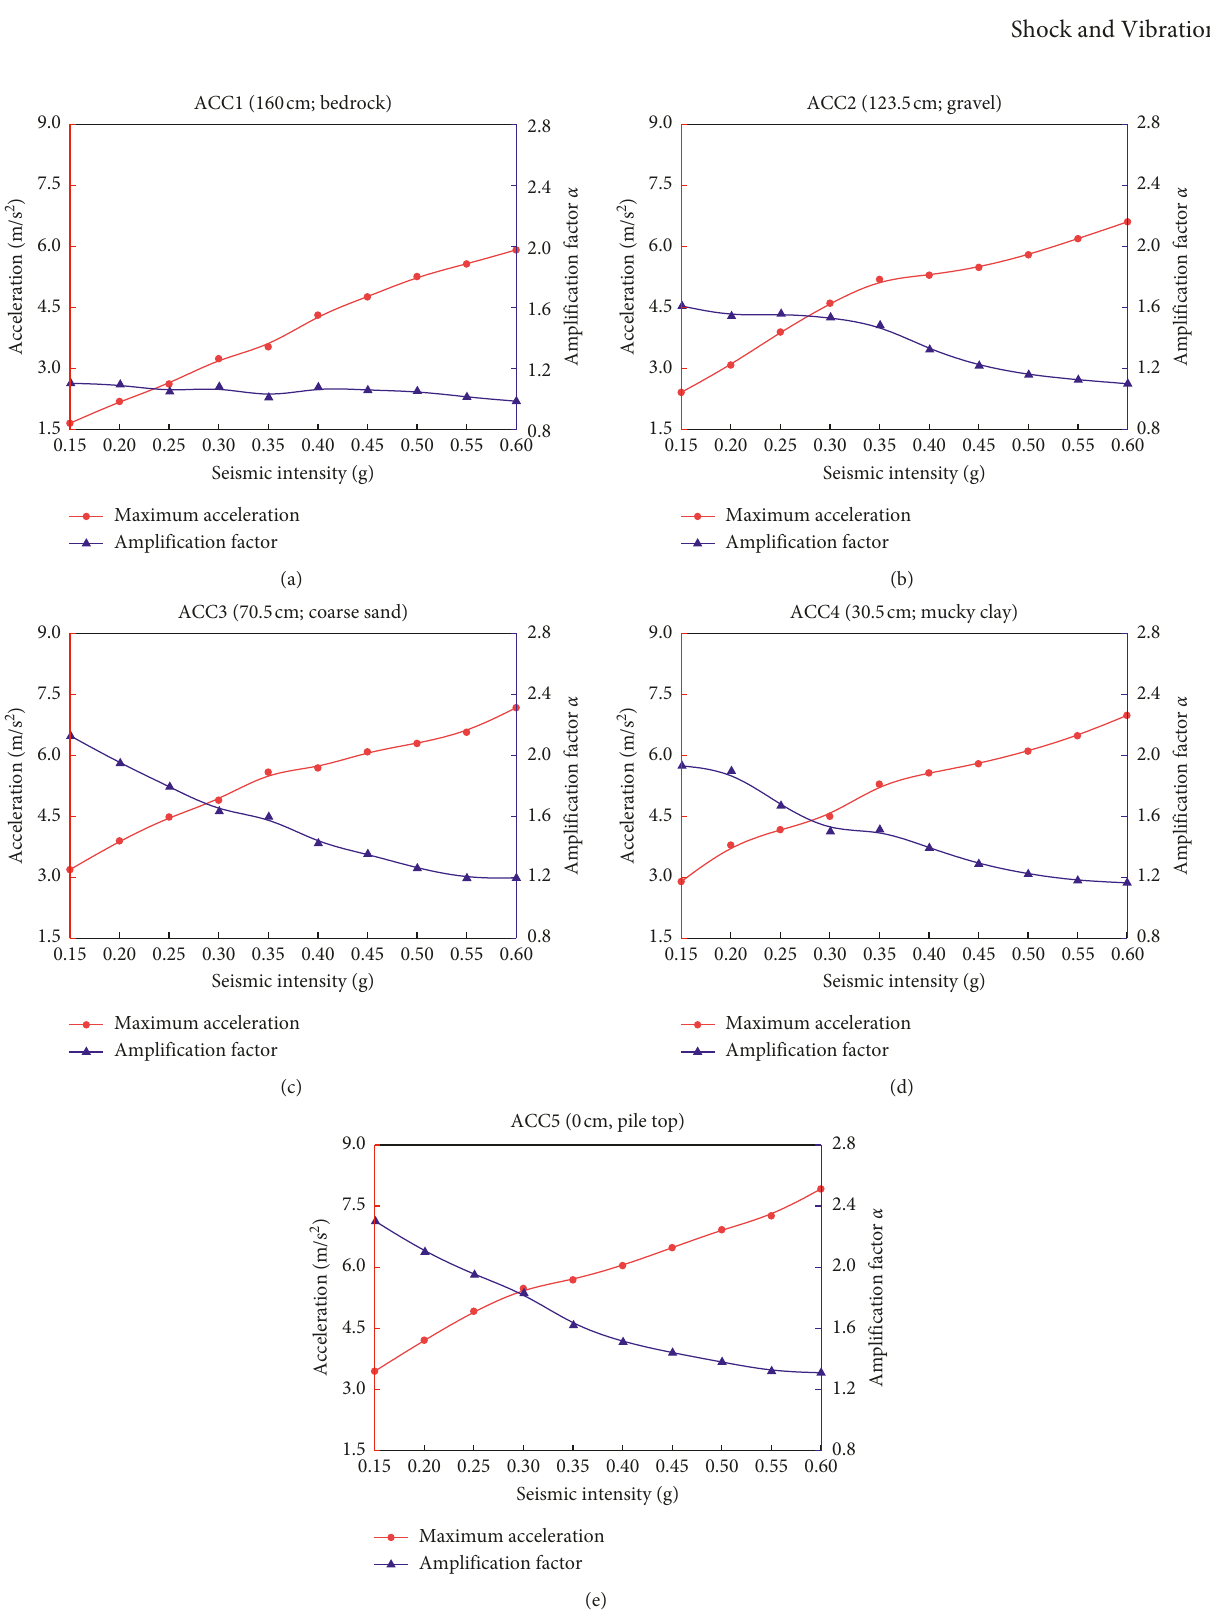
Figure 12: The maximum acceleration values and amplification factors of the pile: (a) ACC1; (b) ACC2; (c) ACC3; (d) ACC4; (e)